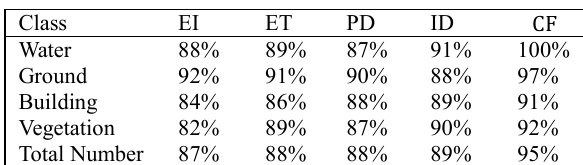
Figure 12. Confusion matrix of different methods, Where Fig.12 (a) is the confusion matrix of EI, Fig.12 (b) is the confusion matrix of ET, Fig.12(c) is the confusion matrix of PD, Fig.12 (d) is the confusion matrix of ID, Fig.12 (e) is the confusion matrix of Feature combination.